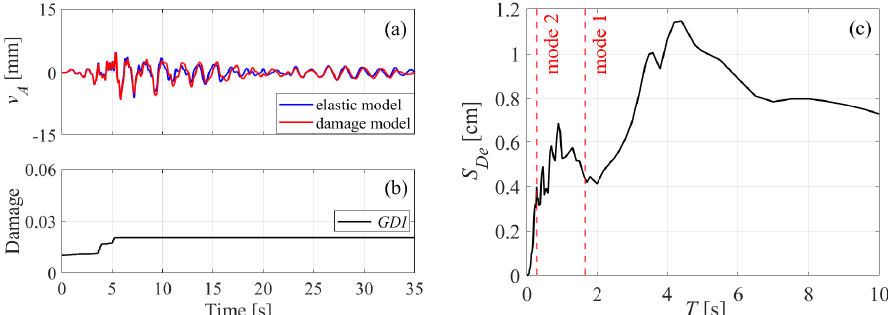
Figure 20. Earthquake MMO station: ( a ) elastic and damage responses of the equivalent pier, ( b ) evolution of the GDI , ( c ) elastic displacement spectrum.